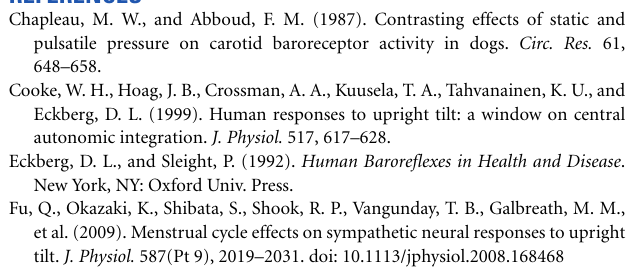
are set at 1, 0.07, 1.4, and 1, respectively, based on observation in animals. (C) Simulated time series changes in BRP (solid lines, upper panels) and SNA (lower panels) at conditions set in (A) and (B) . The dotted lines in upper panels indicate the tilt-induced perturbations. The RAPID test results in greater activation and an overshoot of SNA compared to SLOW and VERYSLOW tests. (D) Simulated SNA data (same as C ) of the RAPID (open circle), SLOW (closed triangle), and VERYSLOW (closed circle) HUT tests plotted on the same axes. Upper X-axis indicates that data are averaged over every 10 ◦ tilt angle during inclinationfrom0 ◦ supine to30 ◦ HUT, whilethe lower X-axisindicates that data are averaged over every 1min after reaching 30 ◦